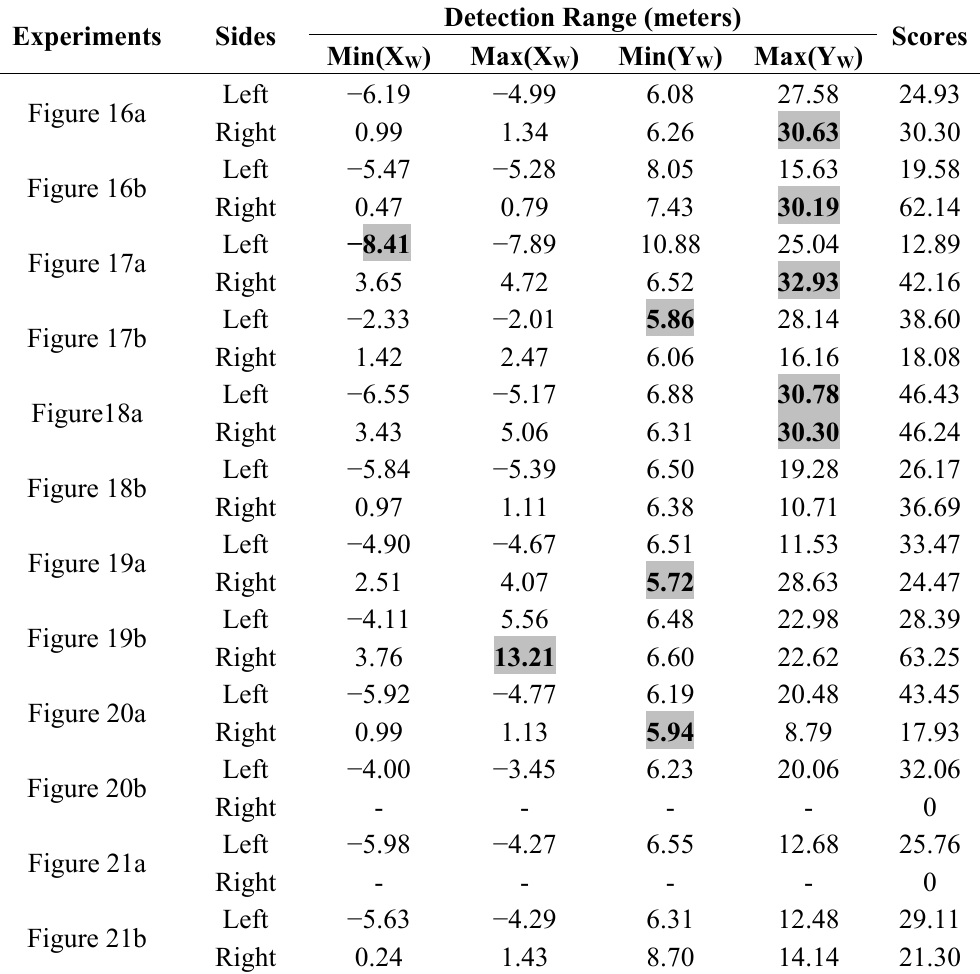
Table 1. Detection range and confidence scores of each